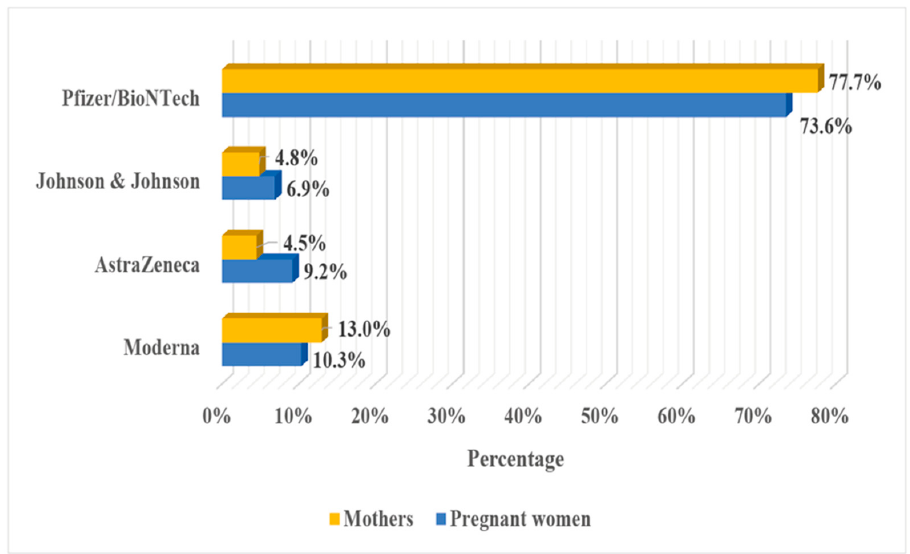
Figure 2. COVID ‐ 19 vaccine. Figure 2. COVID-19